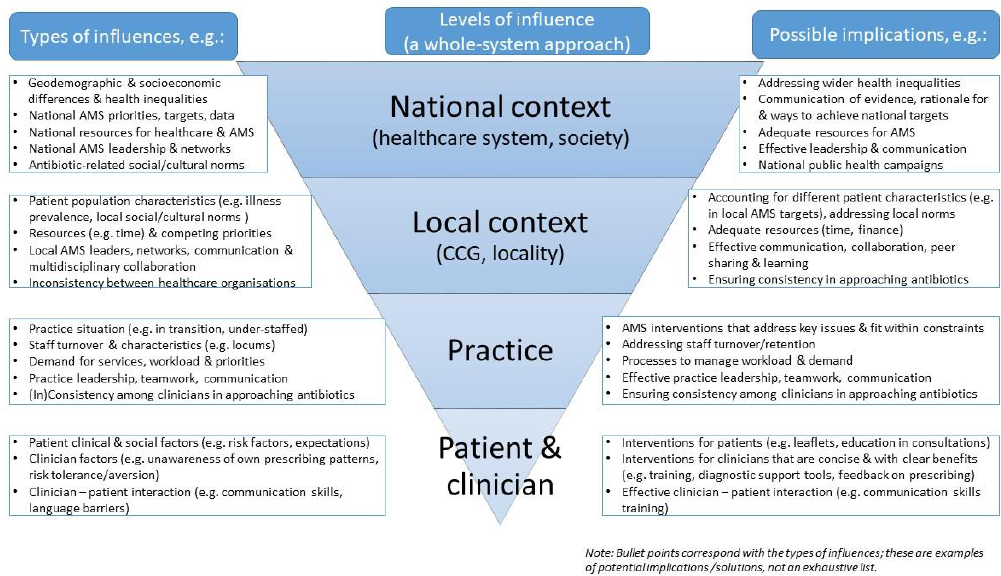
Figure 1. Summary of social and contextual influences on antibiotic prescribing and antimicrobial stewardship (AMS).